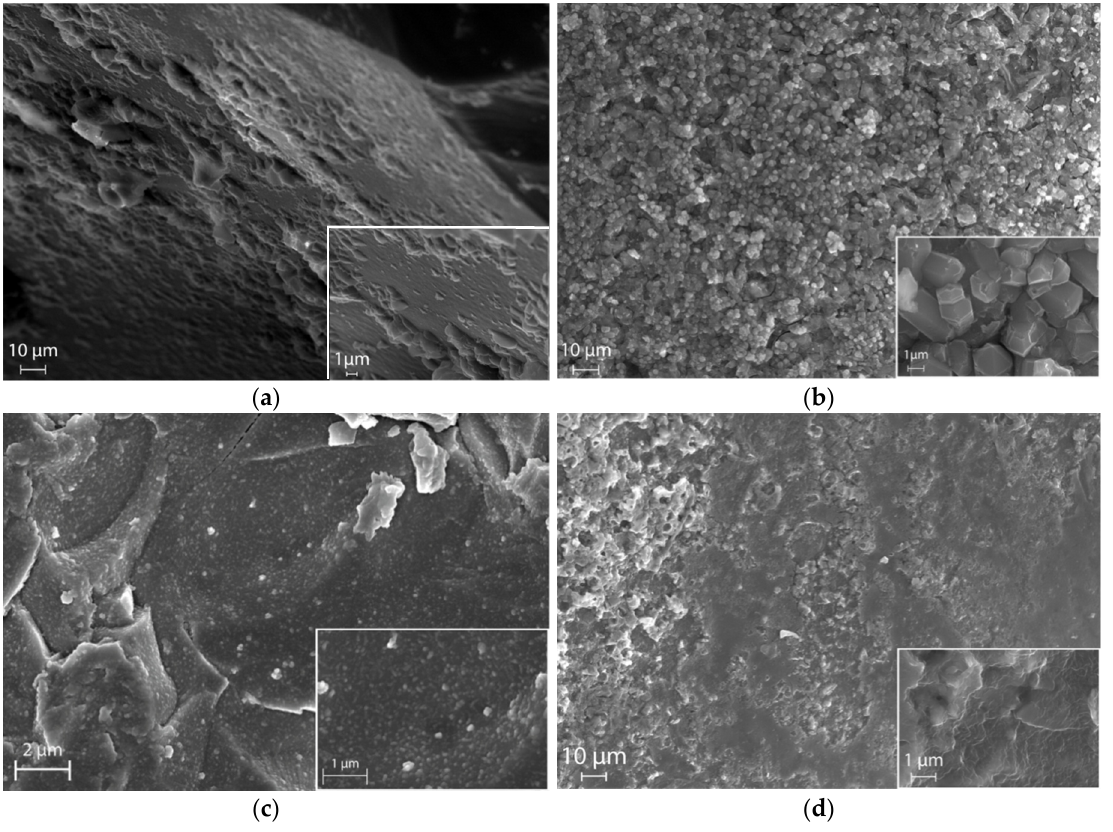
Figure 6. SEM-image of the surface of the original KFeSi ( a ); LiFeSi glass obtained as a result of ion exchange in LiNO 3 ( b ); NaFeSi glass obtained as a result of ion exchange in NaNO 3 ( c ); NaFeSi-based composite containing BaSrTiO 3 ( d ).